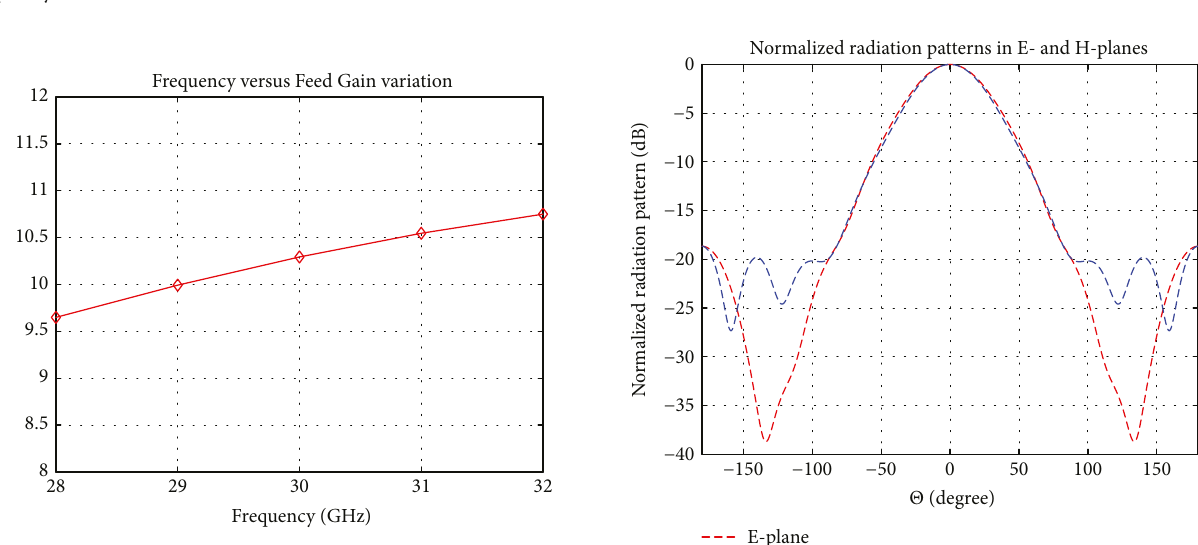
Figure 3: Simulated re fl ection coe ffi cient magnitude versus frequency of the feed.